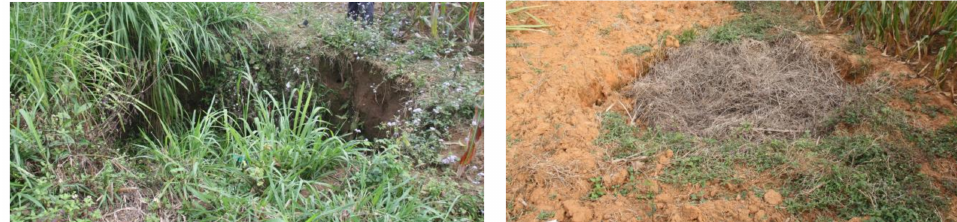
Figure 5. Typical karst